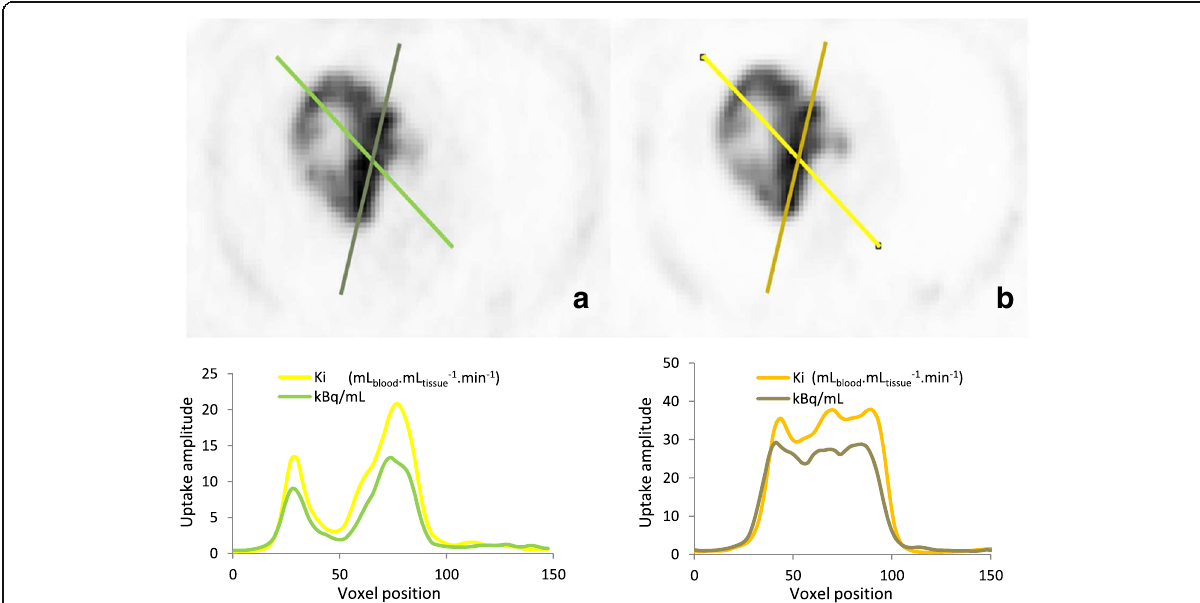
Fig. 7 Example of profiles drawn through the lesion of the SUV ( a ) and K i ( b ) PET images; K i and SUV images were normalised to the background activity of the SUV image